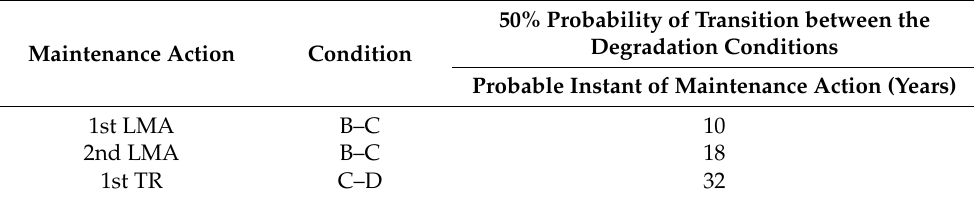
Table 4. Instants for the maintenance actions in ETICS considering the second maintenance strategy (MS2), considering a time horizon of 40